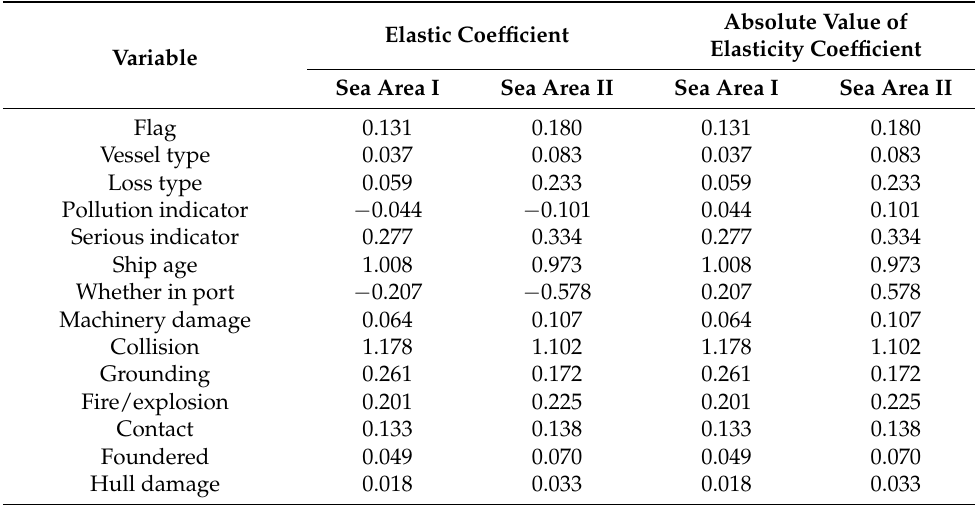
Table 5. Elastic analysis results of the zero-inflated negative binomial